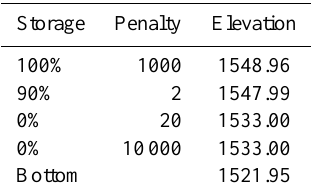
Table 2. Example of reservoir zones and penalty structure in the WRYM. Source: WRYM User Guide – 4.1.1.